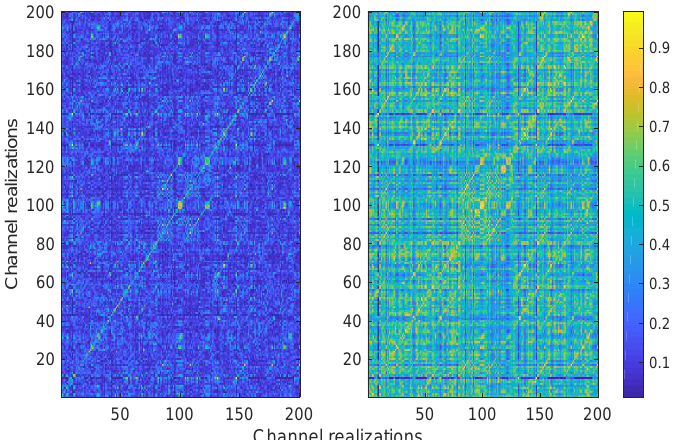
(cid:12) (cid:12) (cid:12) ρ H (cid:12) ( left ) and ρ H abs ( right ) of the channel transfer functions for